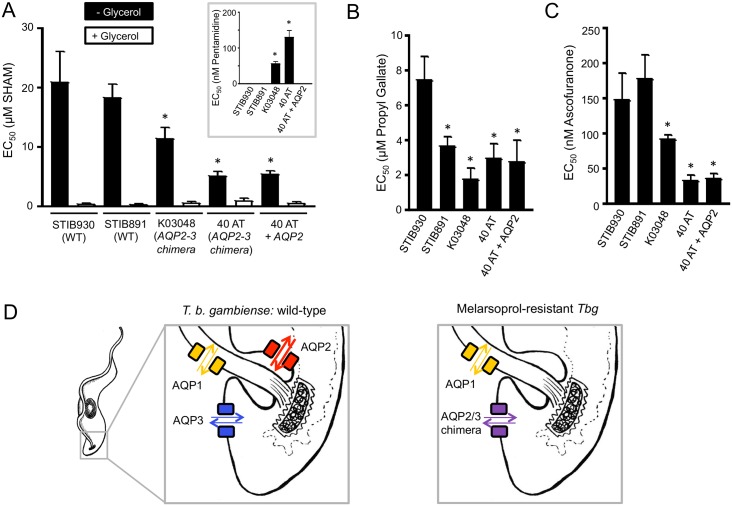
Respiratory inhibitor-sensitivity in T. b. gambiense isolates and AQP-mediated glycerol transport.(A) SHAM EC50 values for the T. b gambiense strains are indicated +/- glycerol. The inset shows pentamidine EC50 values. * indicates significantly different (P<0.05) to STIB930 using an ANOVA test in GraphPad Prism. All pairwise comparisons +/- 10 mM glycerol also indicated significant (P <0.001) differences using a Student’s t-test. Error bars, SD. (B) Propyl gallate and (C) Ascofuranone EC50 values. Other details as in A. (D) Model for glycerol transport by AQPs in T. b. gambiense. The weight of the arrows indicates relative impact on glycerol utilisation and efflux, with AQP2 being the major contributor; note that transport across both the plasma and glycosomal membranes contributes to glycerol utilisation and efflux, see the text for more details. The right-hand panel indicates the situation in melarsoprol-resistant (reduced melarsoprol uptake) and SHAM-sensitive (reduced glycerol efflux) clinical isolates where a chimeric AQP2/3 replaces AQP2 and AQP3.